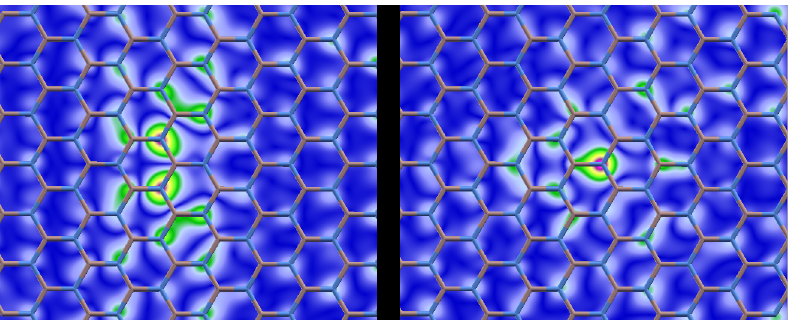
Figure 6: [ Color online ] Lowest excitonic wave-functions, generated by putting the hole on the nitrogen atom. The two wave-functions, one along the strained bond and the other one along the other two binds, are not degenerate anymore in the strained